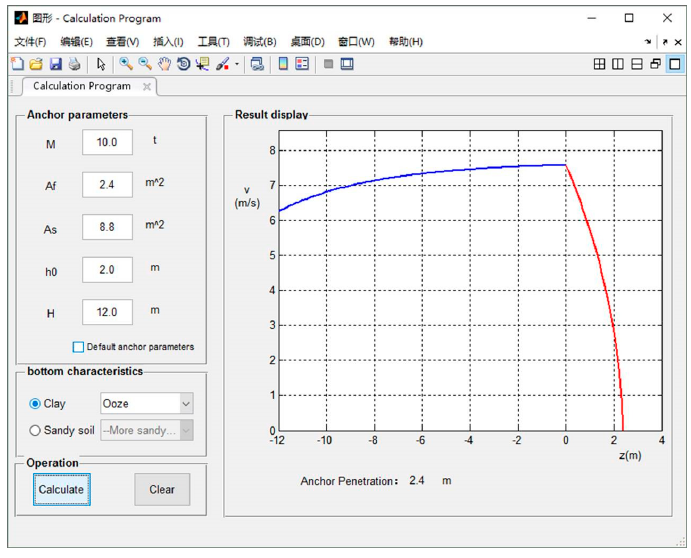
Figure 8. Calculation example.